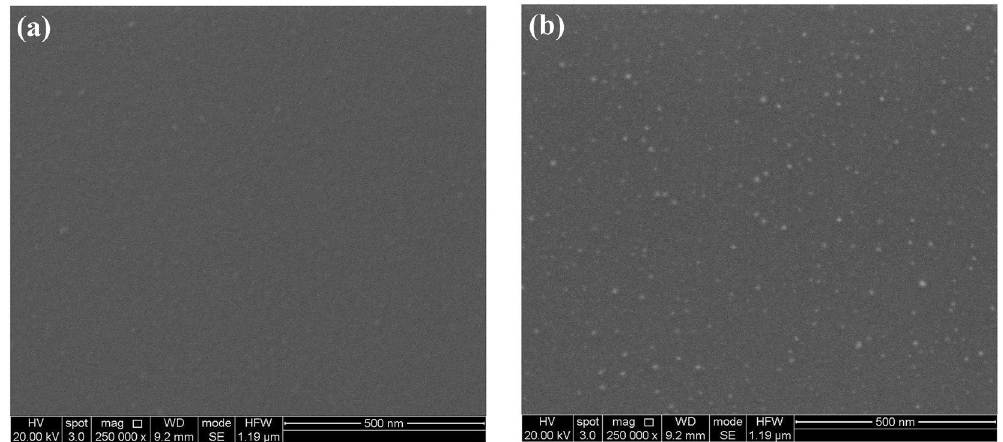
Figure 8. SEM images of B 4 C-coated test wafers taken at 20 kV electron acceleration voltage with a 250 k-fold magnification after cleaning with H 2 /Ar plasma: ( a ) Formerly a-C coated part, and ( b ) non a-C coated